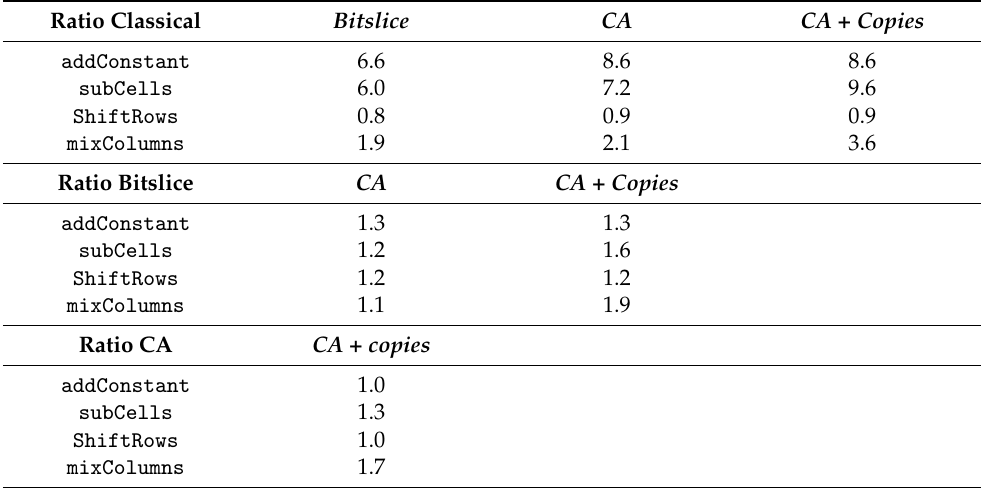
Table 6. Implementation results and cost comparison of the round